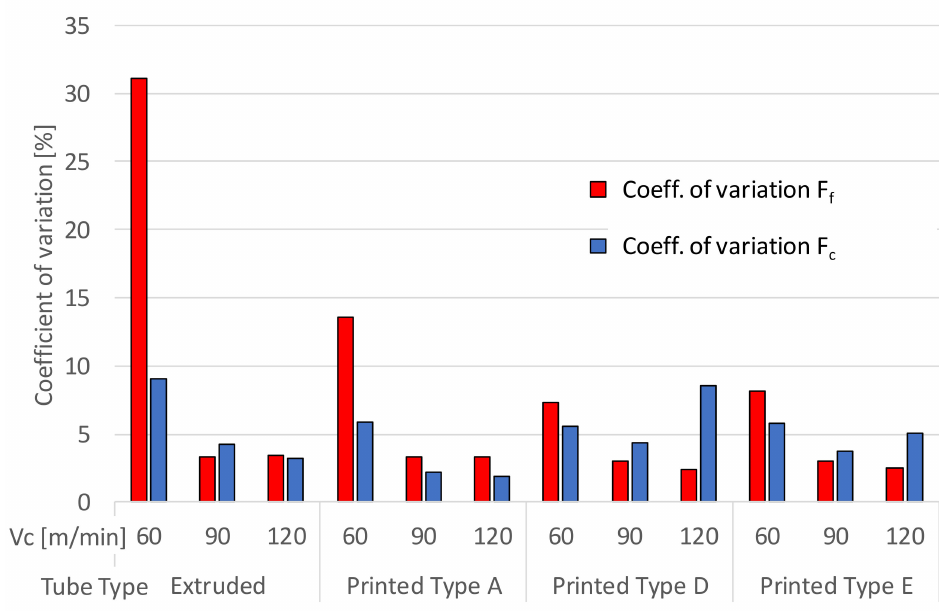
Figure 9. Coe ffi cient of variation (F c and F f ), for the extruded and AM tube